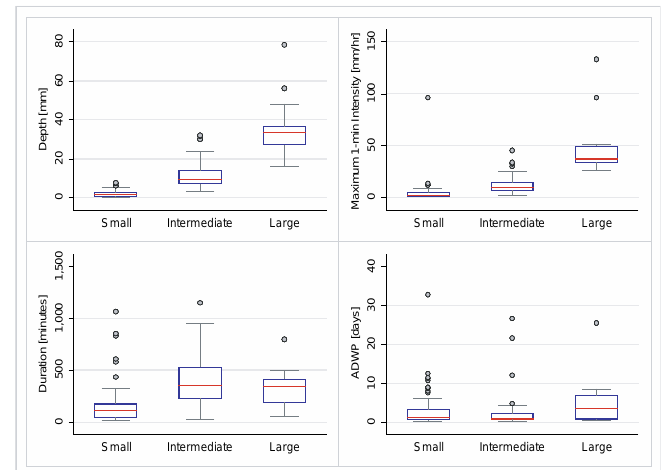
Figure 7. Characteristics of hydrological variables for each event size group.